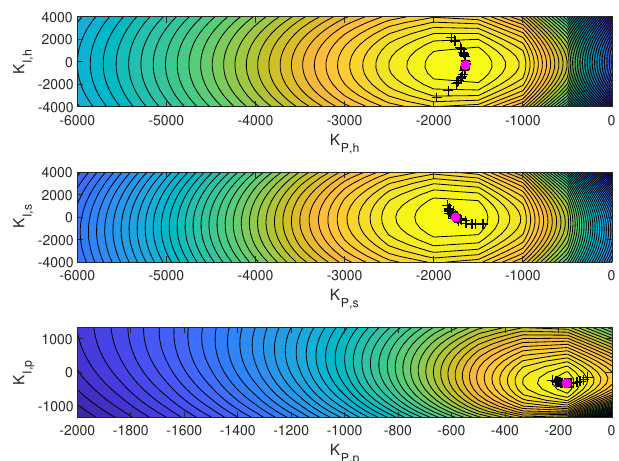
Fig. 14: Gain tunings for 20% uncertainty in the inertial term for sea-state 2A.